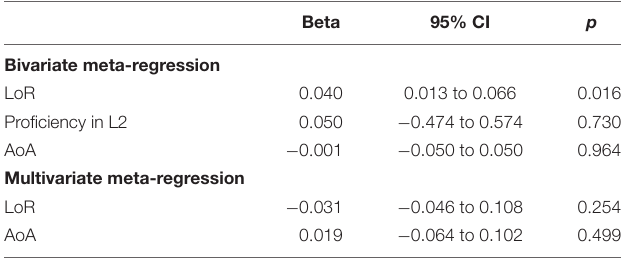
TABLE 4 | Coefficient statistics of meta-regression analysis with RVE estimates on the association between SMD and other covariates. Beta 95% CI